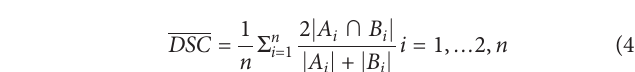
FIGURE 6 | Result of coarse segmentation on CT image of 512 × 512 pixels to 128 × 128 pixels, (A) is CT image of 512 × 512 pixels, (B) is CT image of 128 × 128